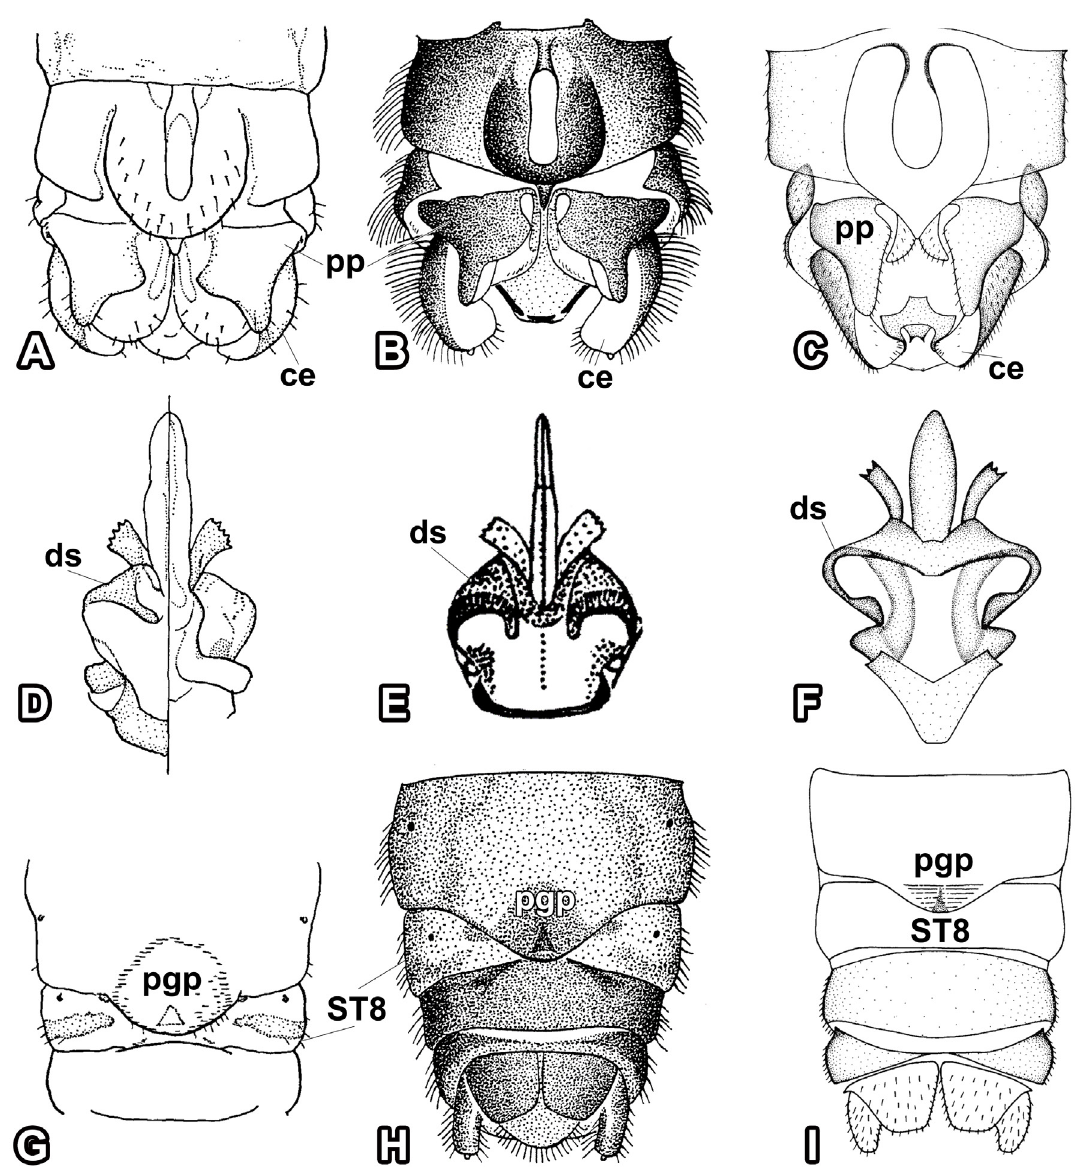
Fig. 6. Drawings of Nemoura geei Wu, 1929. A–C . Male terminalia, ventral view. D . Male epiproct in dorsal view (left) and ventral view (right). E–F . Male epiproct in dorsal view. G–I . Female terminalia, ventral view. A, D and G modified from Shimizu (1997); B, E and H modified from Teslenko & Zhiltzova (2009); C, F and I modified from Yang et al . (2015). Scale bars unavailable from original